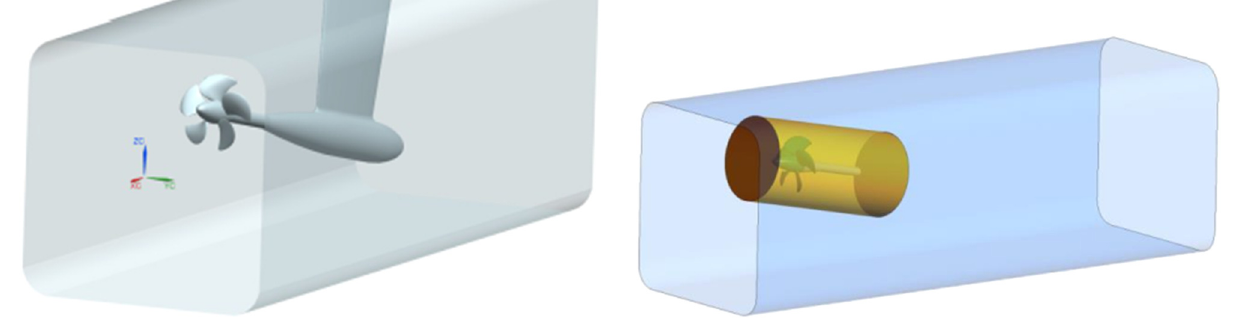
Figure 7: Cavitation test section [ 43 ] . Figure 8: Morgut et al. simulation model [ 44 ]